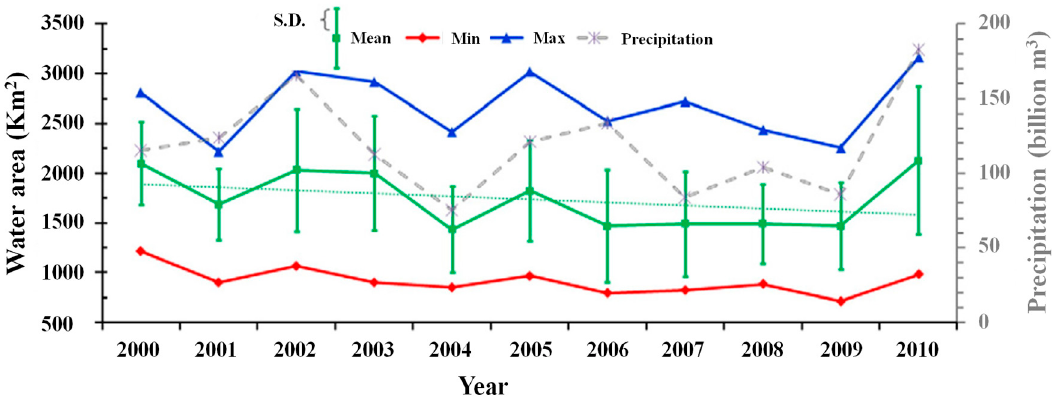
Figure 5. Maximum, minimum, mean, and standard deviation of Poyang inundation areas for each calendar year from 2000 to 2010. The annual mean and standard deviation (S.D.) were derived from the monthly mean. The regression line (dotted line) between annual mean and time shows a significantly declining trend ( modified from Feng et al. [54] ).